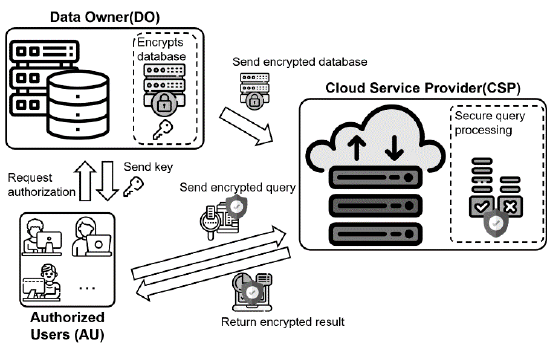
Figure 1. Encrypted database outsourcing